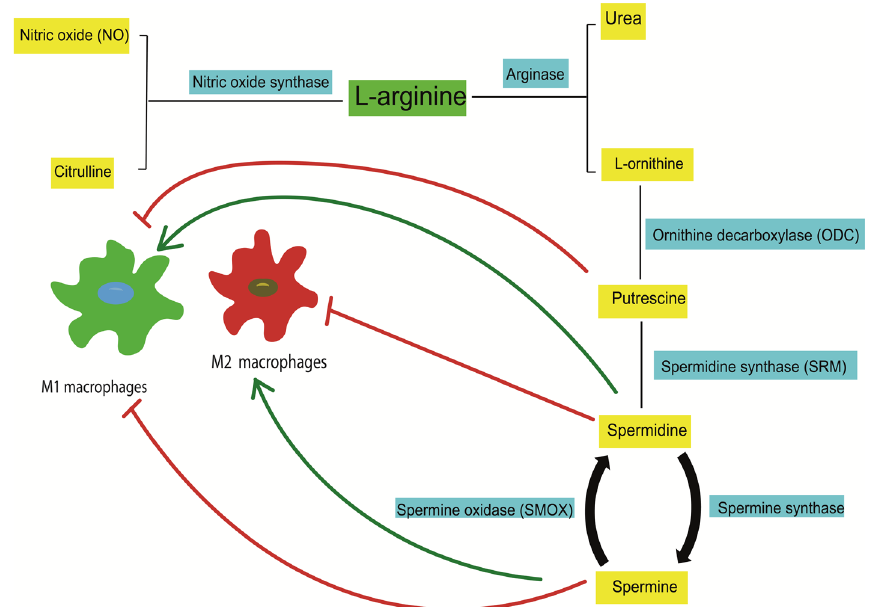
Fig. 2 Mammalian arginine metabolism pathways and M1 and M2 macrophage polarization. Arginine metabolism can be derived via NOS or arginase. NOS, which is expressed in M1 macrophages, causes arginine metabolism to release NO and citrulline, and M2 macrophages synthesize arginase, which causes arginine metabolism to release ornithine and urea. Downstream pathways of ornithine include putrescine, spermidine, and spermine, which hydrolyze products of ODC, SRM, and spermine synthase, respectively. Spermine can be resynthesized to spermidine by SMOX. As shown in the figure, putrescine and spermine downregulate the polarization of the M1 macrophages. Spermidine upregulates M1 macrophage polarization. In the case of M2 macrophage polarization, spermidine and spermine have inhibitor and enhancer effects, respectively. M1 macrophages increase NOS, but M2 macrophages upregulate arginase and ODC. Both arginine metabolic pathways arrest each other. Enzymes are shown by blue boxes and metabolites by yellow boxes, respectively. NOS, nitric oxide synthase; NO, nitric oxide; ODC, ornithine decarboxylase; SRM, spermidine synthase; SMOX, spermine